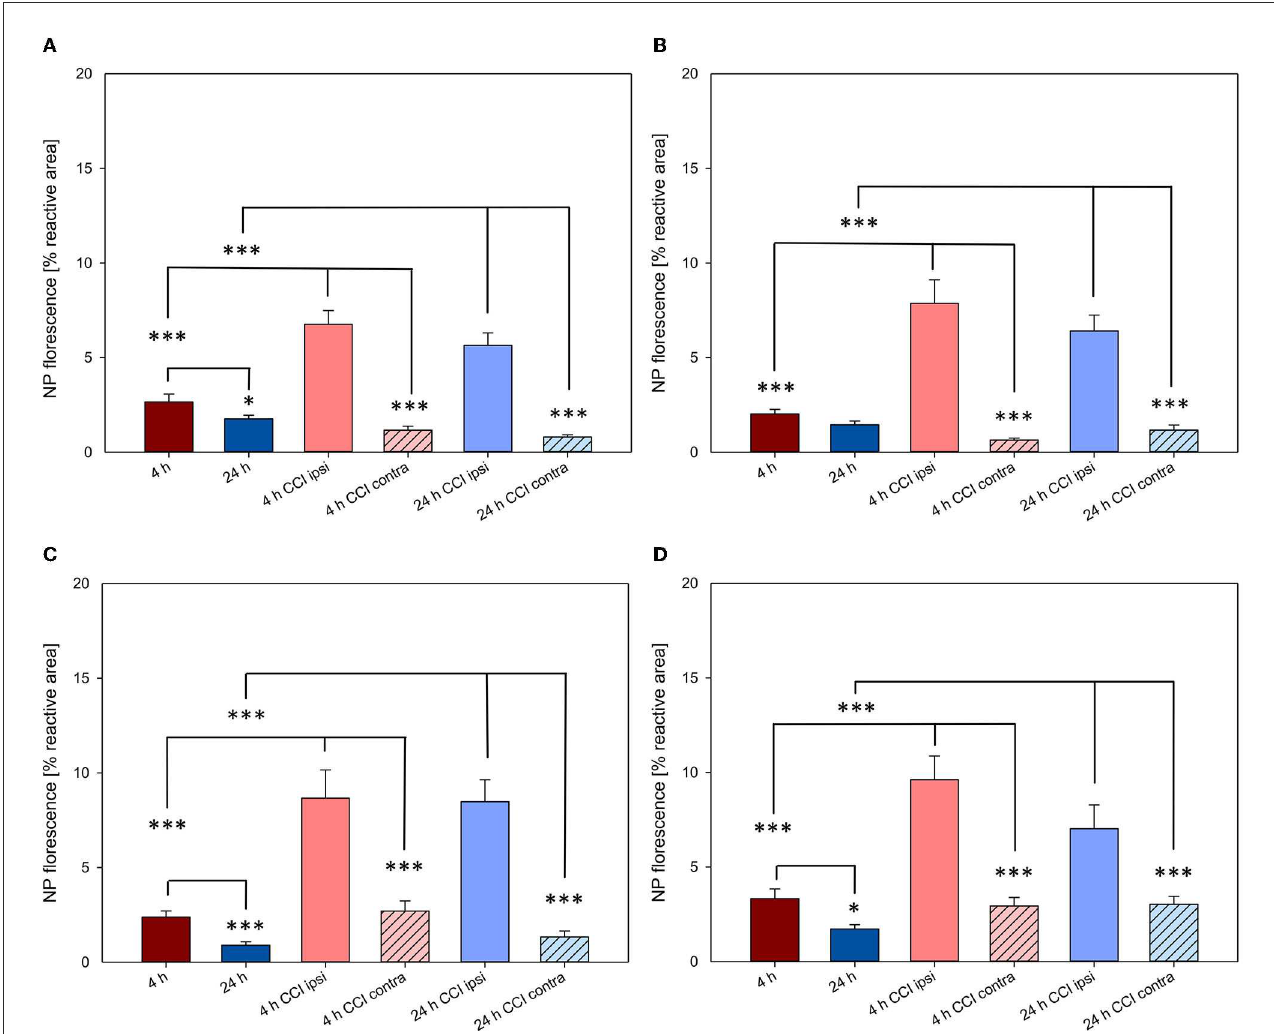
FIGURE7 NP uptake in the brain with and without CCI at 4 and 24h after intravenous application. All NPs showed a higher uptake in the injured hemisphere at both time points. The accumulation of PFDL-Tw (A) , PFDL-SDS (B) , PLLA-Tw (C) , and PLLA-SDS (D) nanoparticles in the brain was assessed as the percentage of reactive fluorescent area in relation to the total area of the ROI at 40 × magnification. One-way ANOVAs were used to compare NP uptake in brains without CCI (ROI within the right parietal cortex, Bregma − 3.00mm), with the lesioned area (ipsi CCI) and the mirrored ROI on the contralateral hemisphere (contra CCI) of traumatized brains. Bars express means ± SEM. *** p < 0.001, * p <